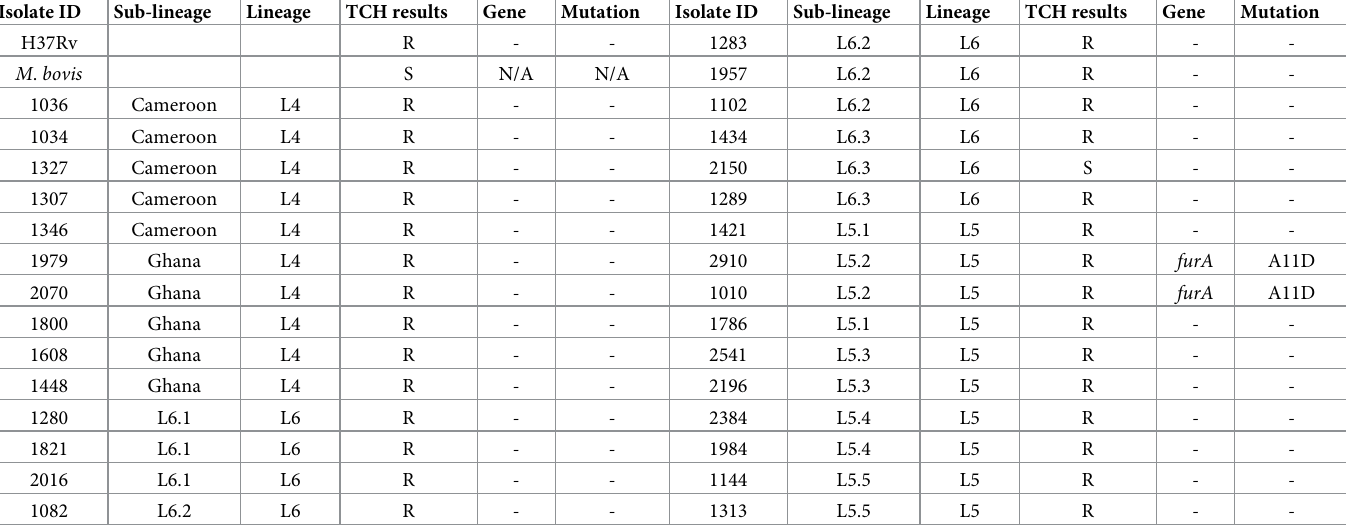
Table 5. Thiophen-2-carboxylic acid hydrazide (TCH) susceptibility profile. Isolate ID